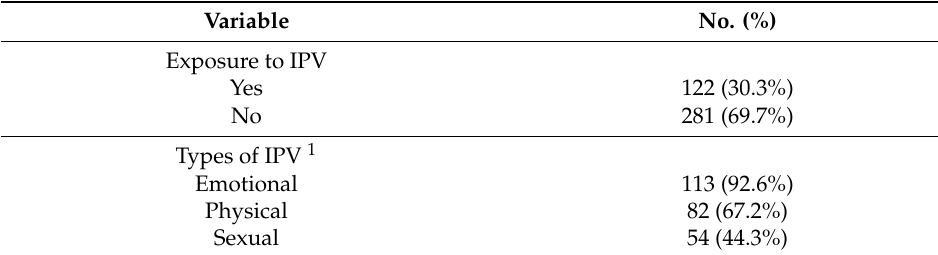
Table 1. Prevalence and types of IPV among women attending different primary health centers in the Aljouf region, Saudi Arabia.